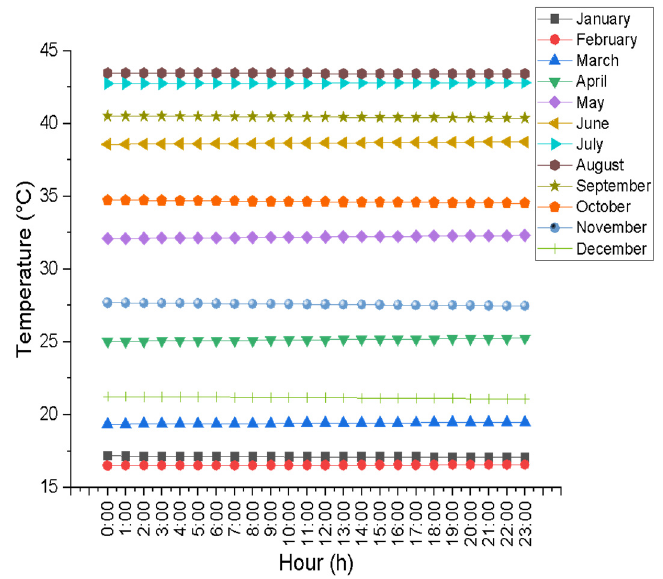
Figure 17. Daily behavior of subsoil temperatures at different months.